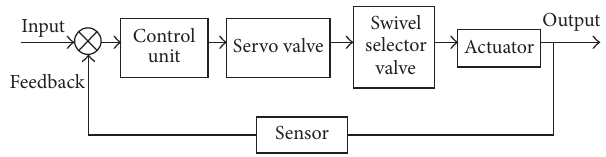
Figure 10: Basic control principle of the steering